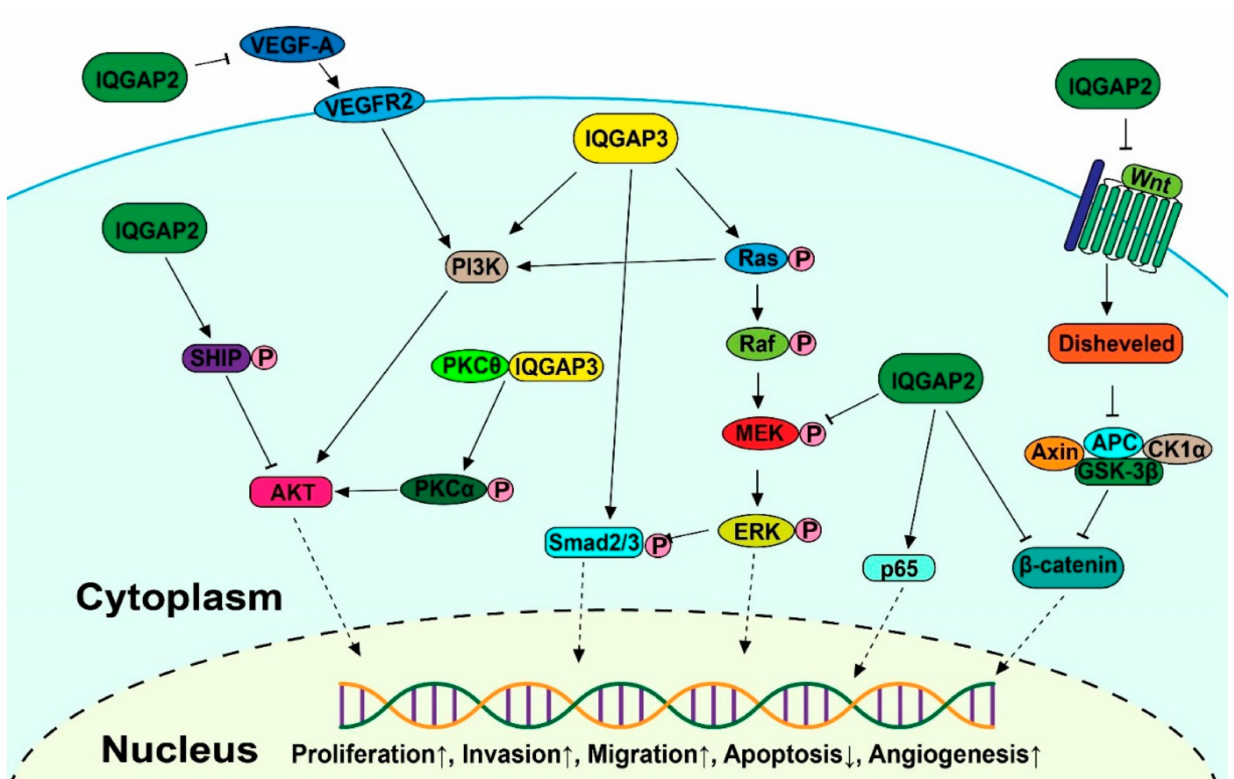
Figure 2. Schematic diagram of the IQGAP-mediated signaling pathways involved in carcinogenesis (Permission obtain from OA journal: